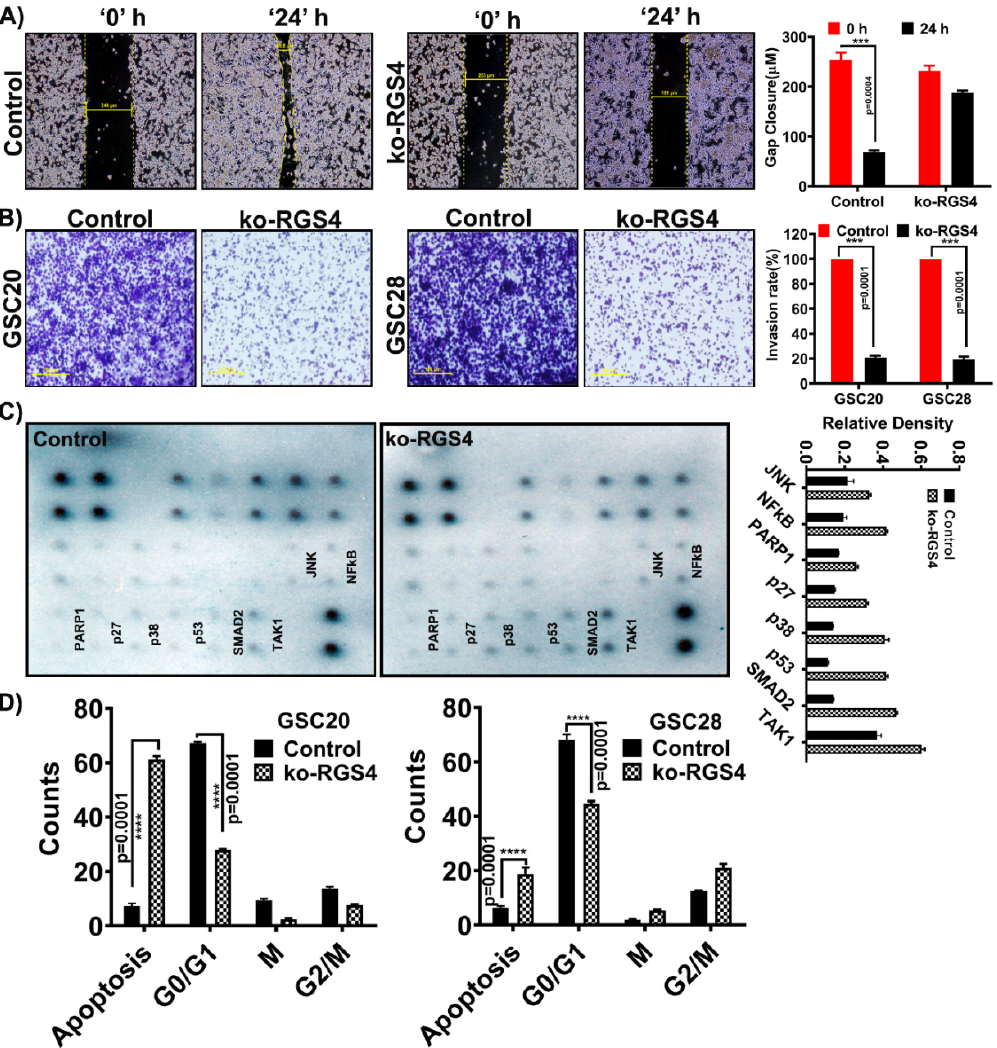
Figure 5. Functional analysis of targeting RGS4 in GSC. ( A ) GSC20 cells were cultured on Poly-D-Lysine- coated six-well plate and treated with ko-RGS4. After 48 h of transfection, a straight scratch was made in individual wells. This point was considered 0 h, and the width of wound was photographed under a microscope. After 24 h, cells were checked for wound healing and again photographed under a microscope. Wound closure distances were used to plot the bar graph ( p = 0.001, n = 3) (*** p = 0.004). Yellow bar explains the percentage of wound contraction / repair (Bar = 100 µ M). ( B ) Using Matrigel plug invasion assay, ko-RGS4-treated GSC20 / GSC28 cells and untreated control cells were plated in a six-well plate. After 24 h, cells penetrating the membrane were fixed and stained with 0.1% crystal violet. The pictograms were captured using an Olympus IX71 microscope. The percent invasion was calculated by taking the untreated control cell invasion as 100% and the treatments were compared against the controls. The data are presented as a bar graph ( p = 0.001, n = 3) (*** p = 0.001) (Bar = 100 µ M). ( C ) Using a human apoptosis signaling pathway array (Ray Biotech AAH-APOSIG), we recorded increased expression levels of apoptosis markers such as PARP1, p27, p53, SMAD and TAK1 and other markers in the ko-RGS4-treated cells when compared to the untreated control cells. The band densities were plotted in a bar graph ( n = 2). ( D ) Cell cycle analysis using flow cytometry confirmed increased apoptosis upon ko-RGS4 treatment. Graphical representation of the percentage of cells in each stage of the cell cycle was represented in a bar graph ( n = 3) (**** p = 0.0001). The error bars are plotted based on the SEM (standard error of mean).